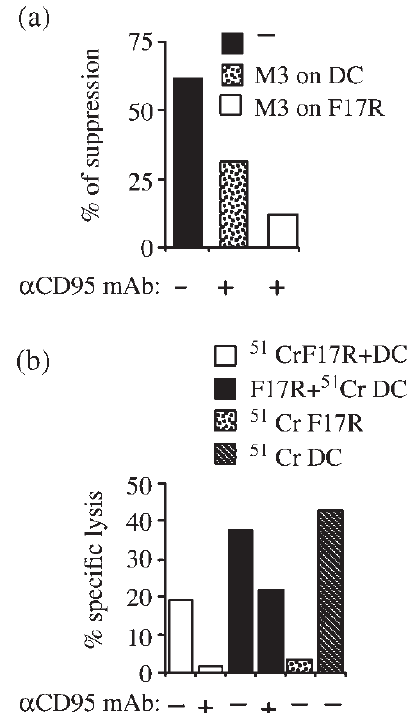
FIGURE 3 Anergic T cells kill both DC and responder T cells, mainly through the CD95-CD95L system. (a) 5 £ 10 3 responder F17 cells were cultured with the specific DC in the absence or in the presence of anergic T cells at anergic/responder cells ratio 3:1. Responder cells and DC cultured in the presence of anergic cells were untreated ( 2 ) or either responder cells (M3 on F17R) or DC (M3 on DC) were pre-treated with 5 m g/ml of antagonistic anti-CD95 antibody (M3). Results are expressed as in Fig. 1. (b) Effector 9 £ 10 3 F17 anergic T cells were cultured with 3 £ 10 3 DRB1*1101 þ unlabeled DC þ 3 £ 10 3 51 Cr-labeled responder F17 ( 51 Cr F17R þ DC) or with 3 £ 10 3 51 Cr-labeled DC þ 3 £ 10 3 unlabeled F17 (F17R þ 51 Cr DC) or with 3 £ 10 3 responder F17 ( 51 Cr F17R) or DC ( 51 Cr DC) alone. The results, expressed as percentage of specific lysis, are representative of two